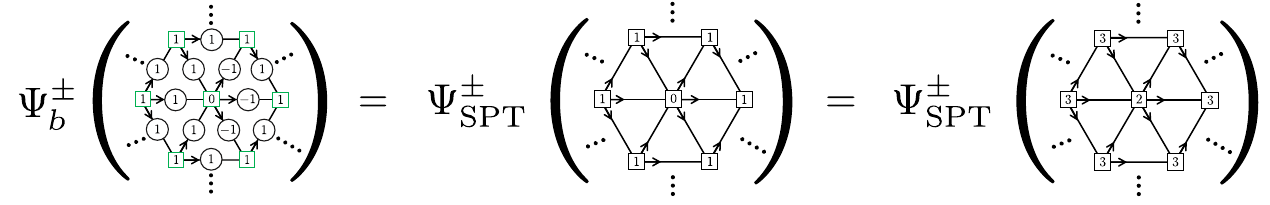
FIG. 6. Example of the amplitude Ψ (cid:2) ðf g p g ; f Z pq gÞ for the G ¼ Z 2 case with nontrivial n , defined in Eq. (28). Here, the argument of b Ψ (cid:2) is a particular configuration with a single j 0 i vertex and all other vertices in the j 1 i state. The link d.o.f. are j 1 i everywhere besides b the three j − 1 i valued links illustrated. The ellipses denote the fact that Ψ (cid:2) is dependent on the global configuration despite the fact that b we have only shown a local portion of the configuration. The amplitude Ψ (cid:2) ðf g p g ; f Z pq gÞ is equivalent to Ψ (cid:2) ðf g ð m p Þ p gÞ if there exists b SPT mp Þ − 1 g ð mq Þ ) for all h pq i . In this example, with ˜ G ¼ Z ϵ ð 0 Þ ¼ ϵ ð 3 Þ ¼ 0 , and ϵ ð 1 Þ ¼ ϵ ð 2 Þ ¼ 1 , two such f g ð m p Þ p g such that Z pq ¼ ð − 1 Þ ϵ ( ð g ð p Þ q 4 , configurations exist. One has a single j 0 i vertex with all other vertices j 1 i while the other has a single j 2 i vertex with all other vertices j 3 i . These two configurations differ by the square of the Z 4 global symmetry generator, so due to the fact that Ψ (cid:2) ðf g ð m p Þ p gÞ is Z 4 SPT symmetric, they give the same amplitude.